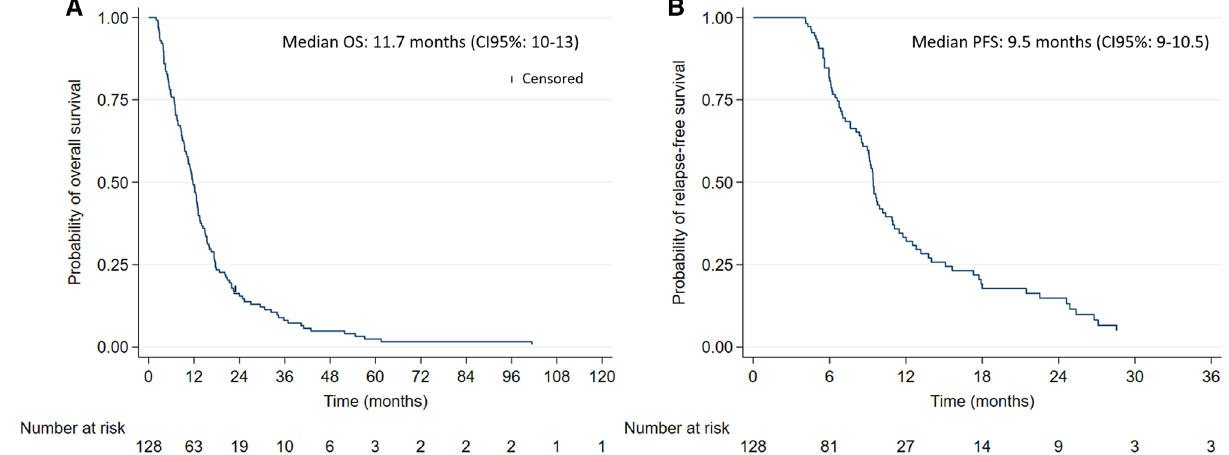
Figure 1. ( A ) Overall survival (OS) and ( B ) progression-free survival (PFS). Median follow-up: 11.7 months (IQR: 6.5–17.5). All patients but 2 had died at the time of analysis: one patient was censored after progression at 20 months and one patient was still alive at 120